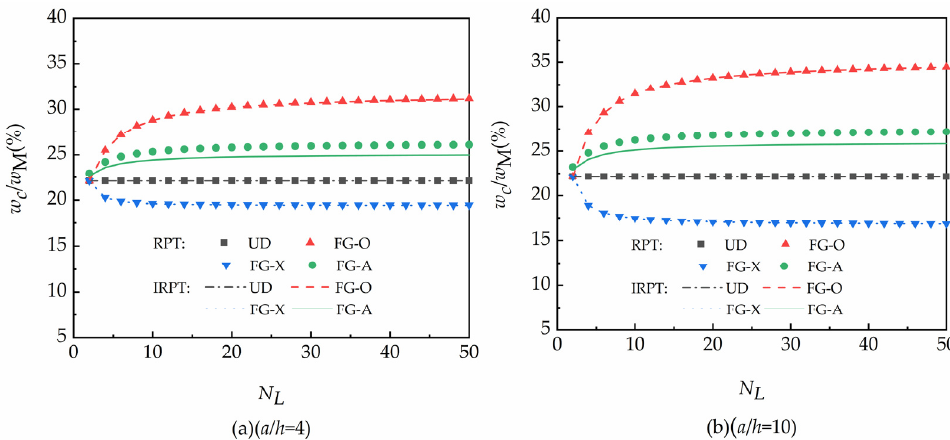
N on the deflection ratio L